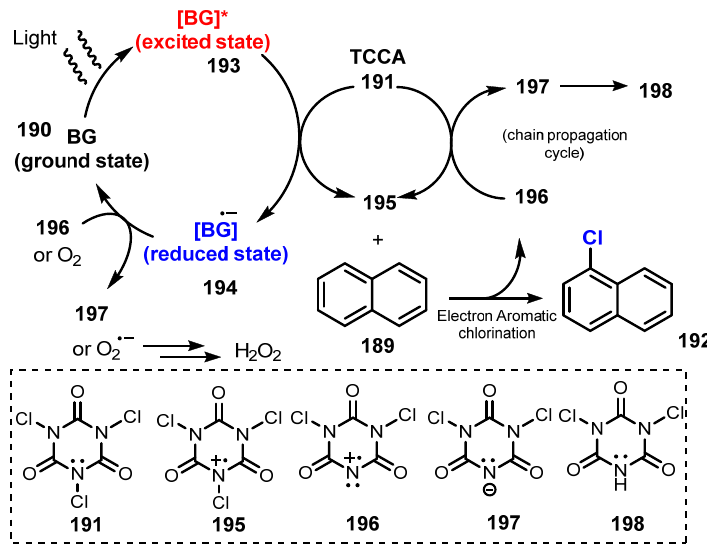
Scheme 52. Mechanism for conversion of arenes and heteroarenes to chlorinated products using organic dye.